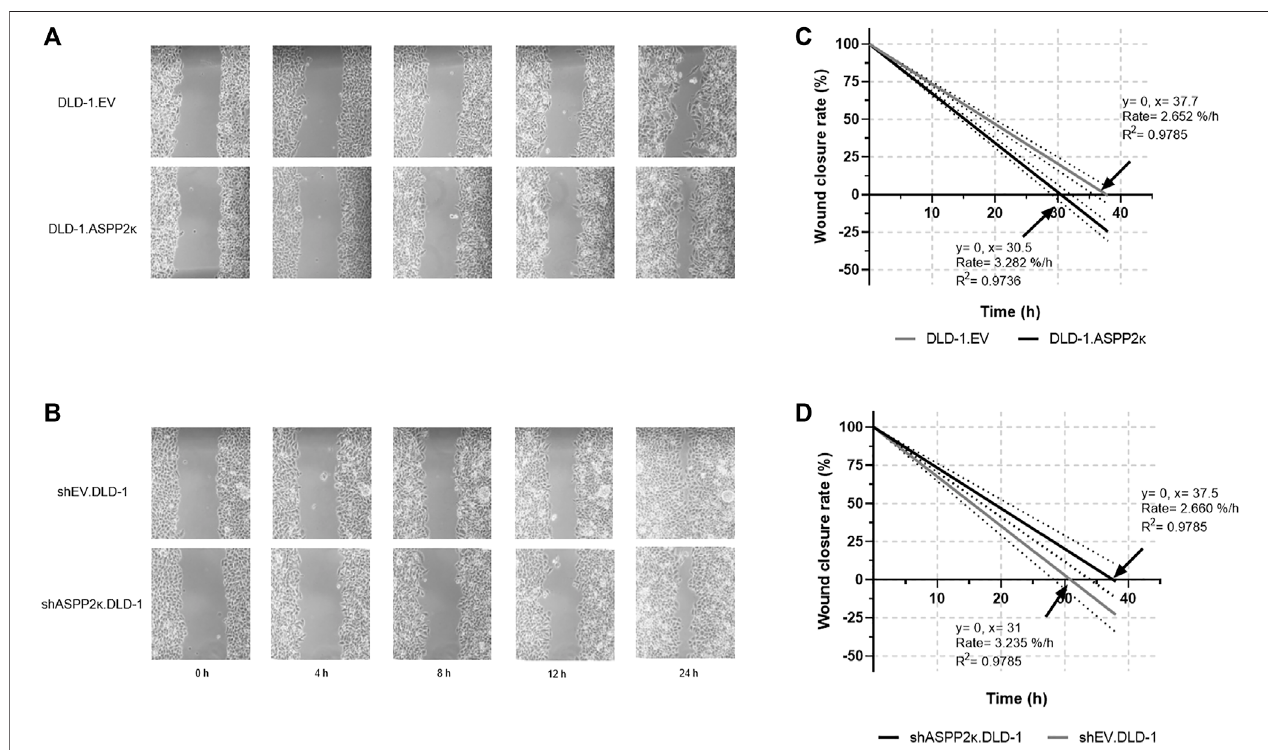
FIGURE 6 | Exemplary wound healing experiments to visualize migratory behaviour of DLD-1.ASPP2 κ (A) or shASPP2 κ .DLD-1 (B) cells are shown. (C,D) Quanti fi cation of migration capacity as determined by wound closure rates of DLD-1.ASPP2 κ (C) or shASPP2 κ .DLD-1 (D) cell strains. EV, empty vector.